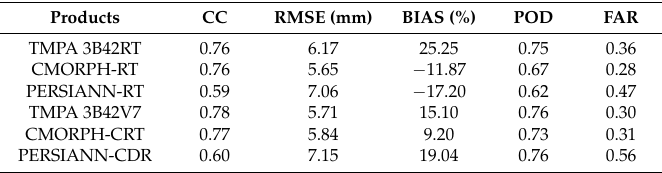
Table 3. Statistical measures of the SPPs for the daily precipitation estimates.